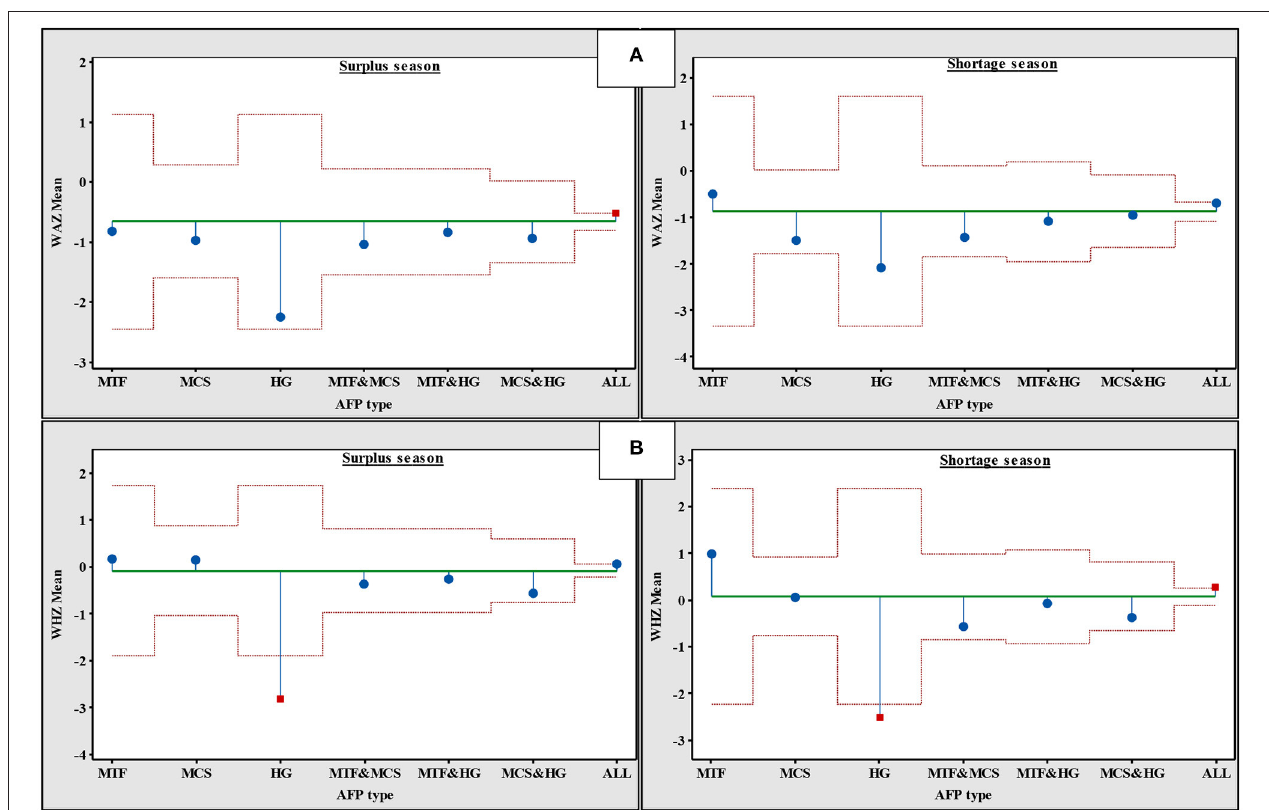
FIGURE 4 | One-way ANOM of WAZ and WHZ across seven AFP combinations in two seasons ( α z -score (WHZ). HG, homegarden; MCS, multi-story coffee system; MTF, multipurpose tree on